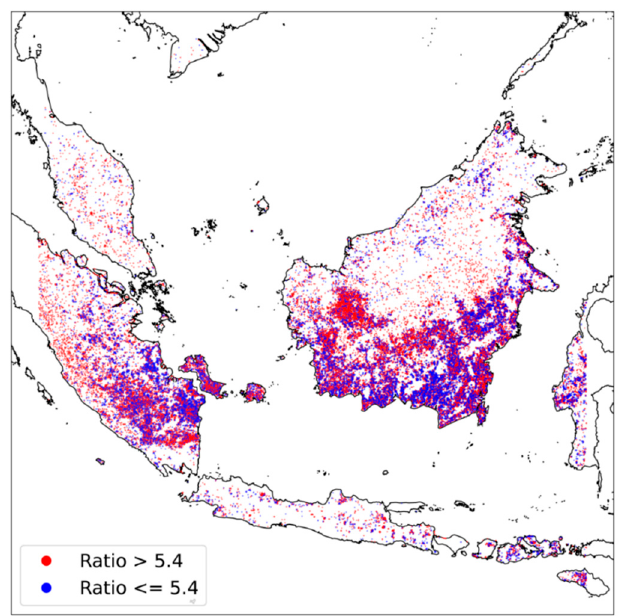
Figure A4. Map of the study region showing gridded (1-arcminute; ~2 km) AHI active fire detection locations for September and October 2015, coloured by the median spectral ratio for each grid cell (defined in Section 4.2).